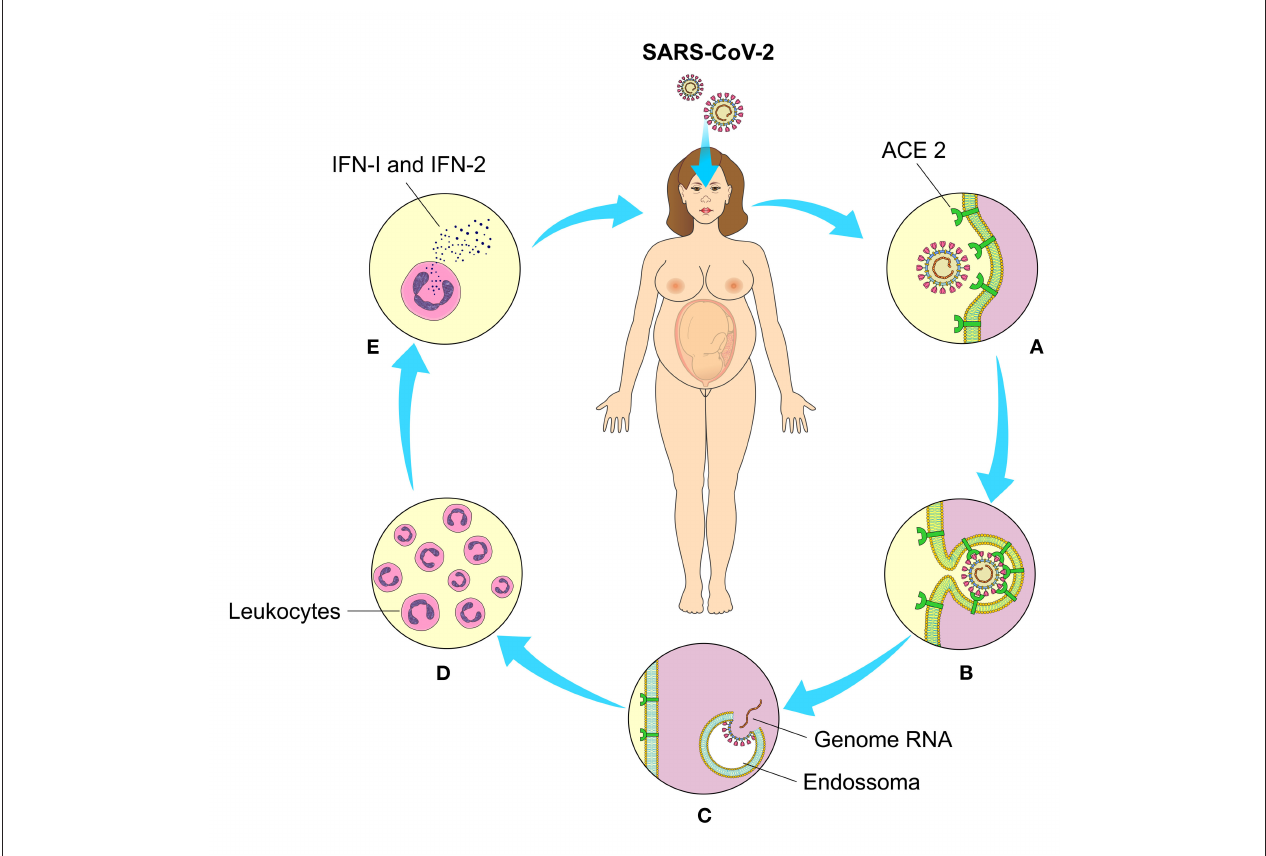
FIGURE 4 | Cell binding, interiorization, and cellular response to SARS-CoV-2. (A) Through their binding to angiotensin 2-converting enzyme (ACE2) on the cell’s surface, (B) the viral penetrates inside the cells and (C) after the enzymatic action of the endosomes release their genetic material (RNA) for the production of the structural components of new viral particles. (D) Intracellular receptors detect viral RNA replication and mediate leukocyte chemotaxis and (E) interferon production (IFN-I and